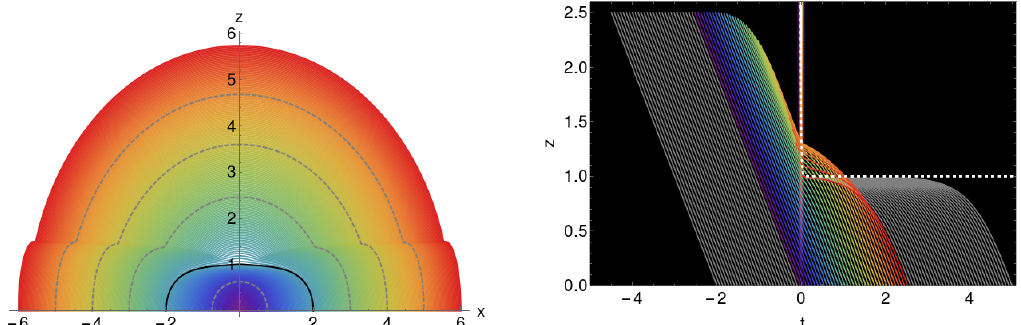
Figure 2: Left: Geodesics for different boundary separation at fixed time t = 2. Gray dashed lines highlight geodesics for l = 2,6,8,10 and the solid black line is for l = 4 which is the separation where the central point of the geodesic, located at x = 0, crosses the matter shell. Right: Geodesics with fixed boundary separation l = 5.0 for different values of the boundary time. The white dashed line is the radial location of the apparent horizon. Colored geodesics cross the matter shell, shown as a density ( z , t ) = z M (cid:48) ( t ) at t ≈ 0, and do not saturate QNEC. Gray lines are plot of T bulk 2 tt geodesics that do not cross the shell and hence saturate QNEC.